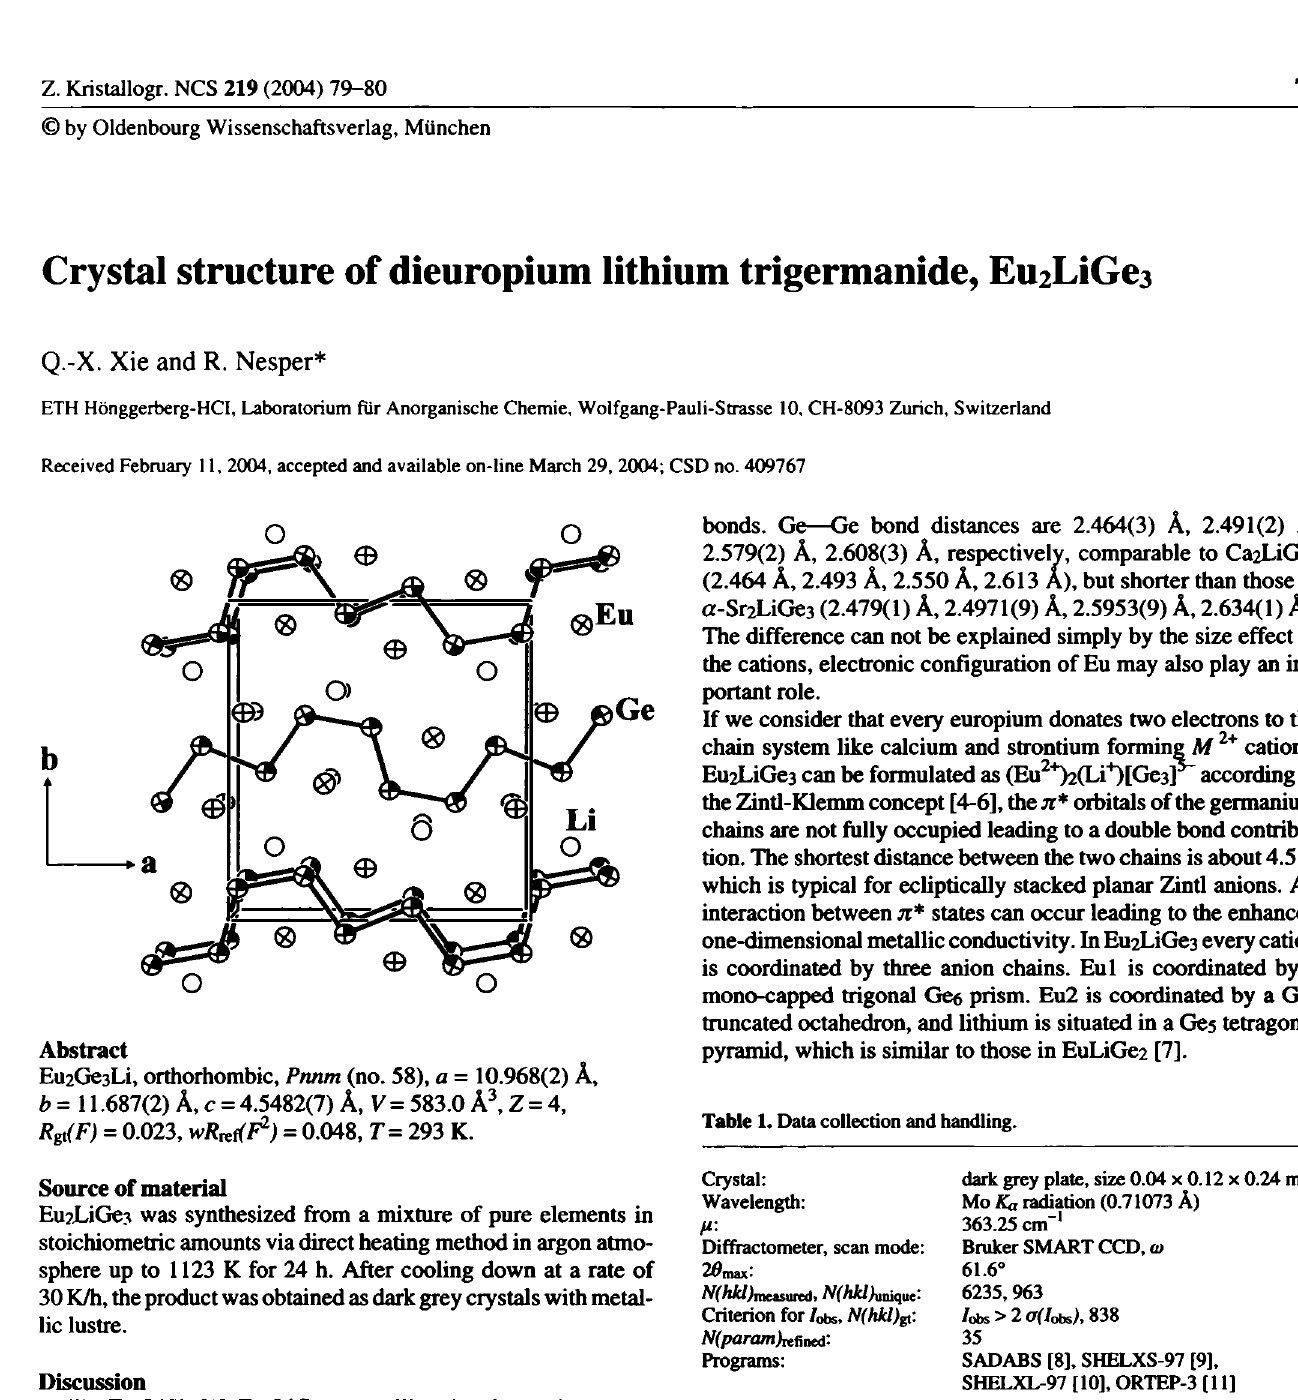
Table 2. Atomic coordinates and displacement parameters (in Ä 2